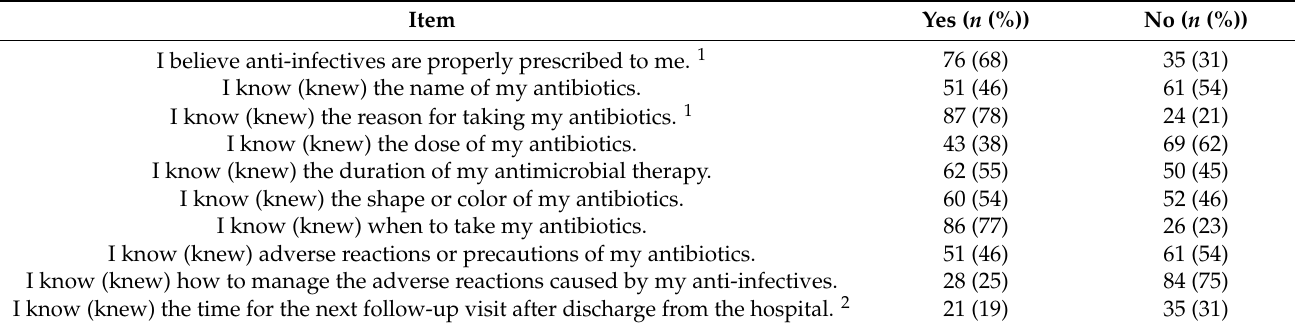
Table 3. Knowledge of antimicrobial use among survey participants ( n = 112). Item Yes ( n (%)) No ( n (%))